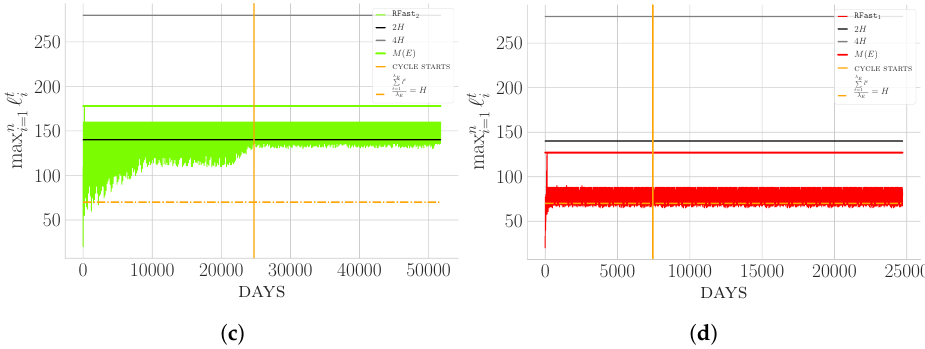
Figure 9. Snapshot of the evolution of maximum heights when strategies: RMin ( a ); RMax ( b ); RFast 2 ( c ); and RFast 1 ( d ) are applied on an instance having n = 30 and H = 70. (in details, structured as follows [ 20;11;8;5;1;1;1;1;1;1;1;1;1;1;1;1;1;1;1;1;1;1;1;1;1;1;1;1;1;1 ] ). On the x -axis the consecutive days are reported while on the y -axis the maximum height on the corresponding day is plot. The vertical line shows the beginning of the periodic phase while the horizontal lines show, respectively, ( (i.e., H ), 2 H , 4 H , and M ( E ) over the entire execution.